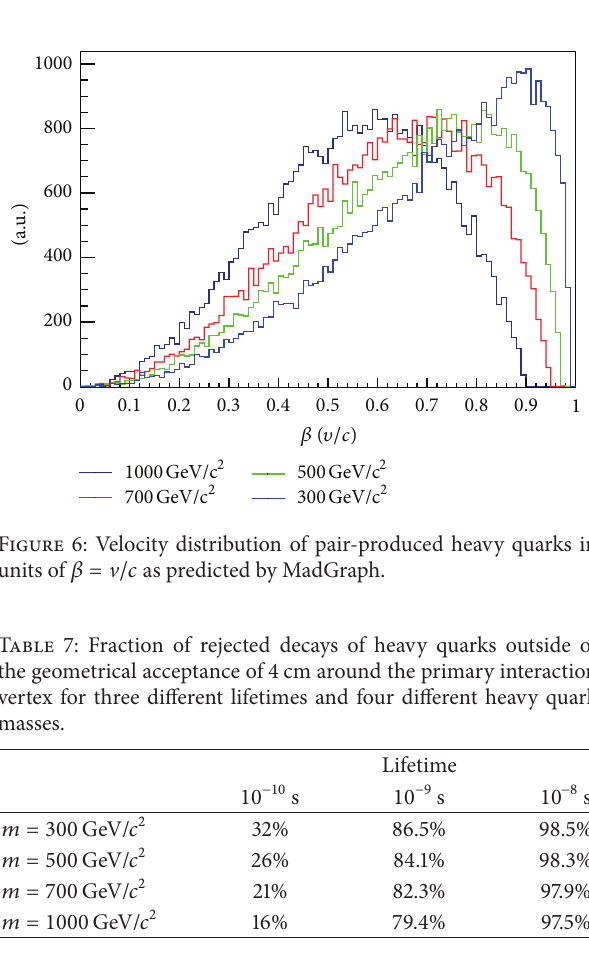
Figure 5: Transverse momentum distribution of pair-produced heavy quarks as predicted by MadGraph.